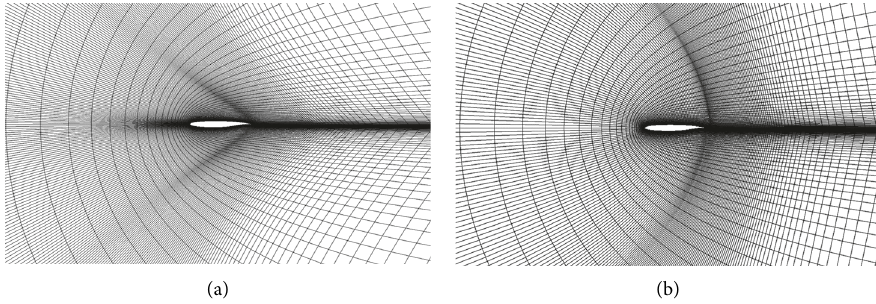
Figure 11: Far-field of the Navier–Stokes meshes optimized without curvature functions. (a) Optimized without orthogonality functions. (b) Optimized with orthogonality functions.